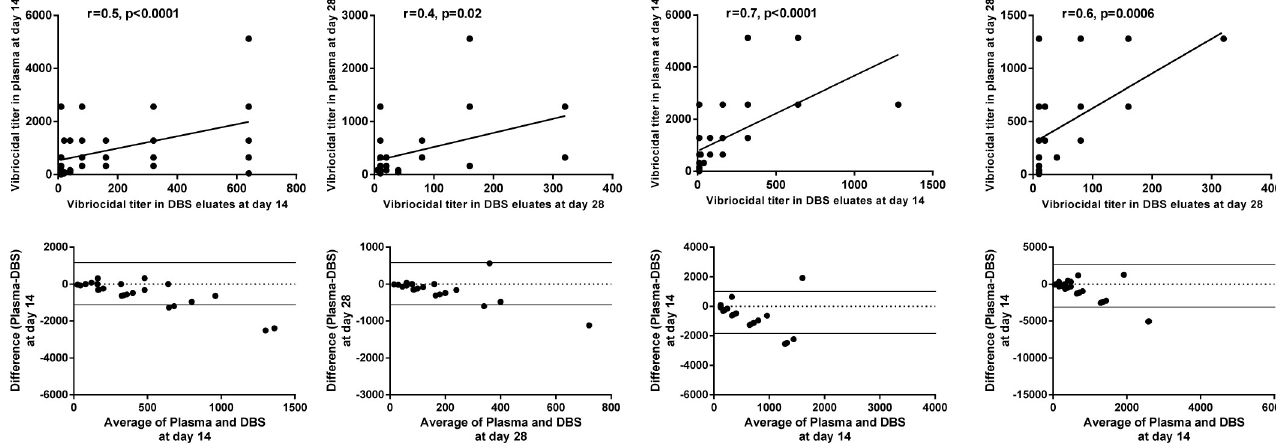
Fig 5. Correlations and the Bland-Altman analysis of vibriocidal antibodies in plasma and DBS eluates to Ogawa serotype in adults and older children. Spearman correlation of vibriocidal responses in plasma and DBS eluates at day 14 and day 28. Bland-Altman analysis of vibriocidal responses in plasma and DBS eluates of OCV recipients of FDMN at day 14 and day